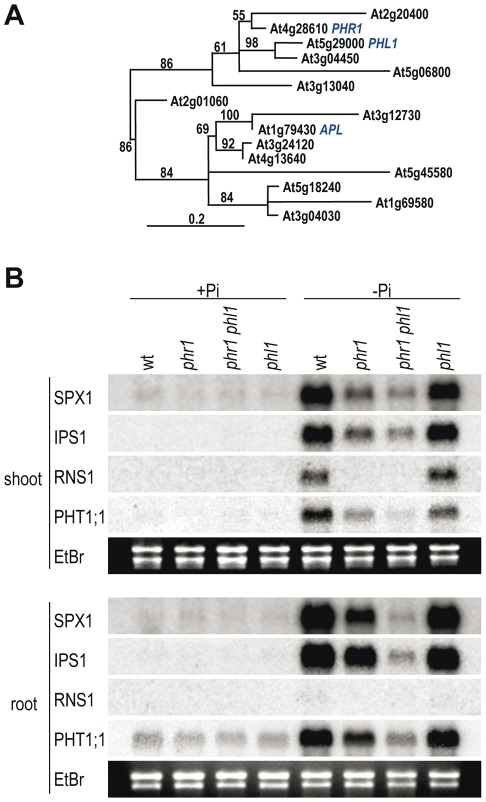
Functional redundancy of PHR1 and PHL1 in Pi starvation responsiveness of gene expression.(A) Phylogram of MYB-CC proteins from Arabidopsis, constructed using the Phylogeny-fr platform (www.phylogeny.fr) [70]. In addition to the AGI number, names are given for the functionally characterized members: PHOSPHATE STARVATION RESPONSE REGULATOR 1 (PHR1) [12]; PHR1-LIKE1 (PHL1; this study) ALTERED PHLOEM DEVELOPMENT (APL) [71]. The bootstrap value of each node is indicated (100 samples); nodes with bootstrap value <50 were collapsed. Only the conserved MYB and coiled-coil domains were used for alignment (Figure S1) and tree construction. (B) Northern analysis of the effect of phr1 and phl1 mutations on the expression of Pi starvation-responsive marker genes. Plants were grown for 7 days in Pi-rich or -lacking medium; RNA from roots and shoots was isolated separately and blots were hybridised sequentially to the probes PHT1;1, RNS1, IPS1, and SPX1. Ethidium bromide-stained rRNA was used as loading control.